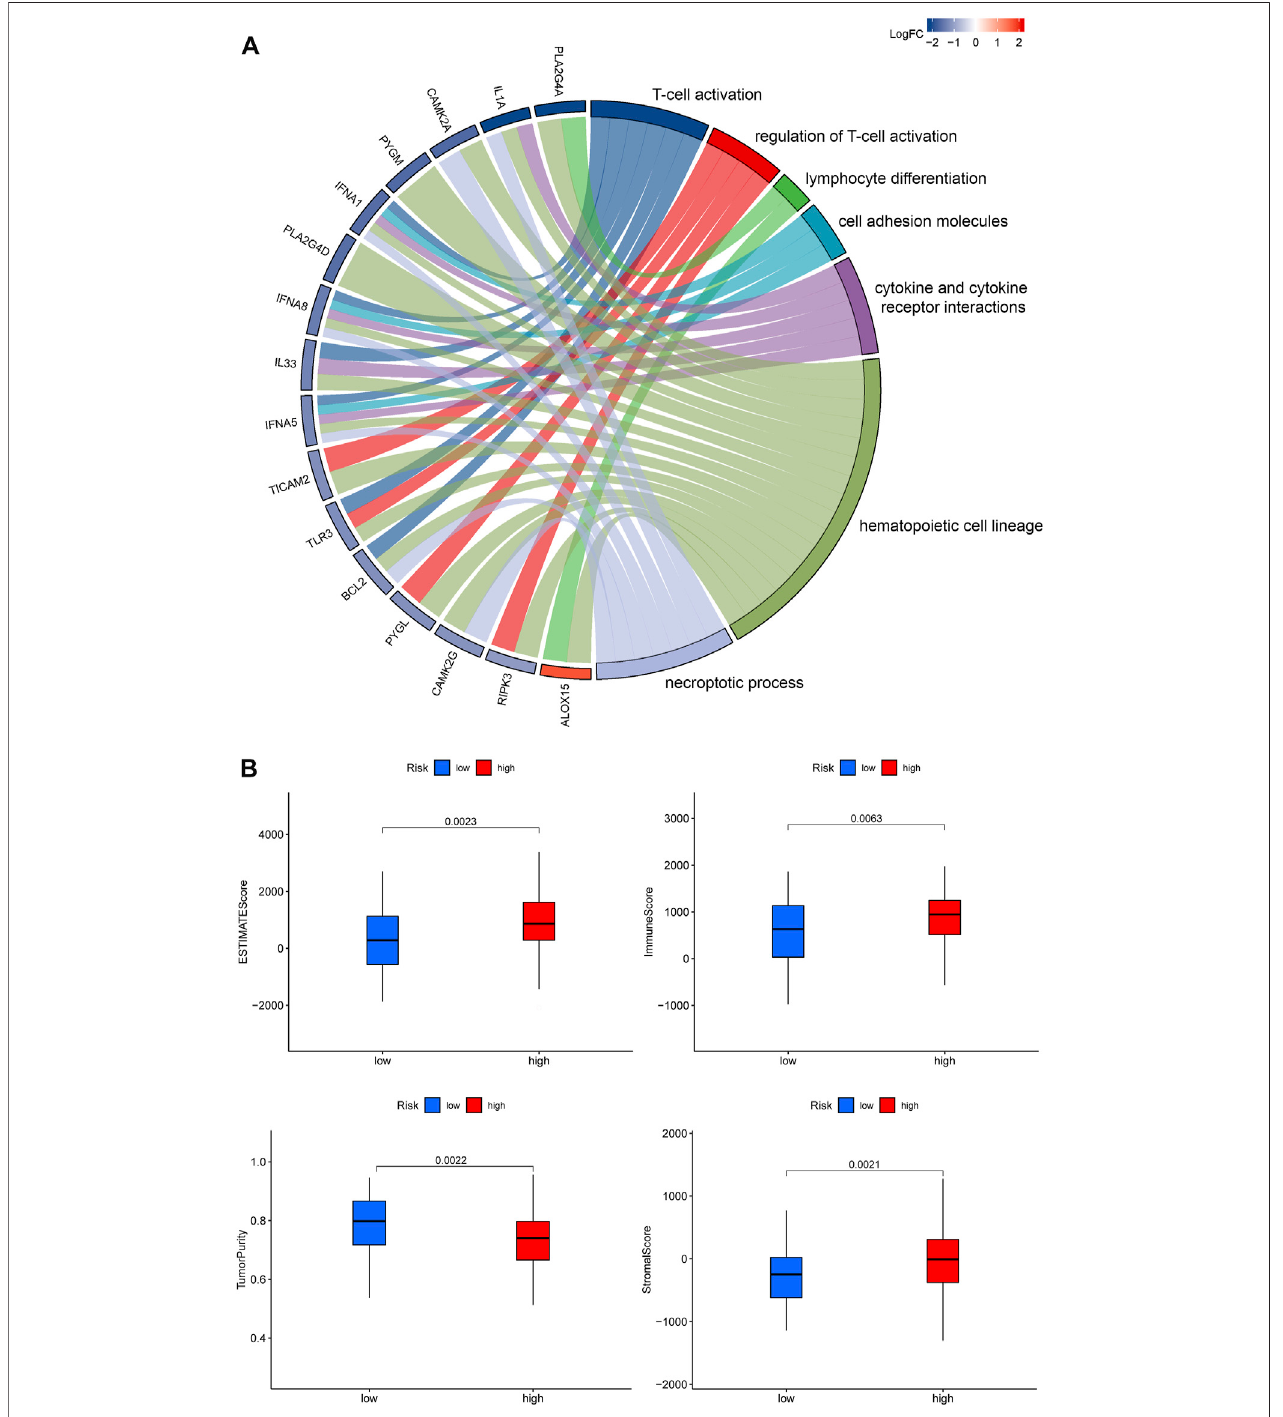
FIGURE 5 | (A) . Pro fi les of GO functional terms and KEGG pathway enrichment for the identi fi ed DEGs (B) . An overview of the ESTIMATE algorithm.